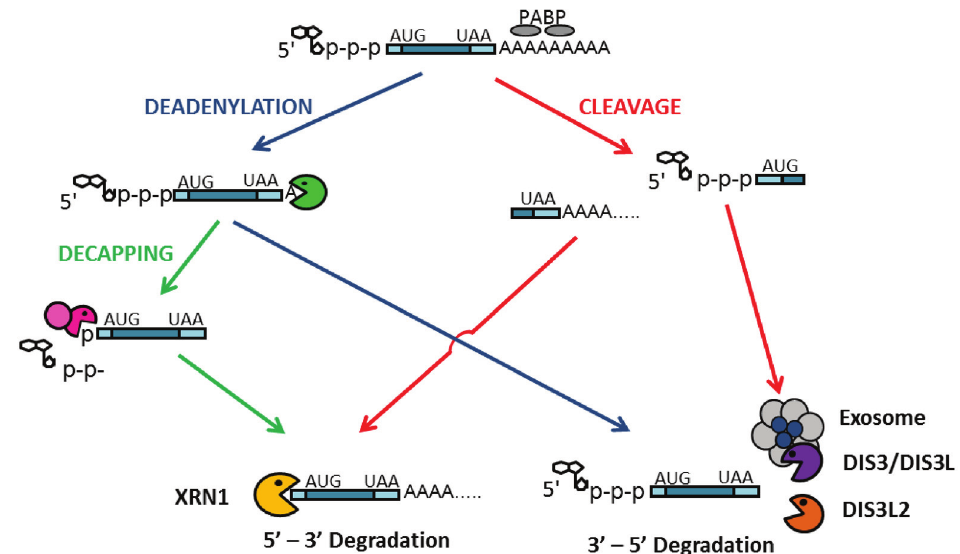
Figure 4. Overview of the mRNA degradation pathways in eukaryotes. Messenger RNAs first undergo removal of the 3' poly-A tail (deadenylation) allowing access for 3' (cid:2) 5' degradation by the exosome complex and DIS3. Following deadenylation the mRNA can undergo removal of the 5' cap (decapping) exposing the mRNA to degradation by the 5' (cid:2) 3' exoribonuclease XRN1. Alternatively mRNAs can undergo endonucleolytic cleavage (e.g., due to RNAi, or nonsense-mediated mRNA decay in some organisms) creating two fragments, each of which is susceptible to either XRN1 or the exosome and the DIS3